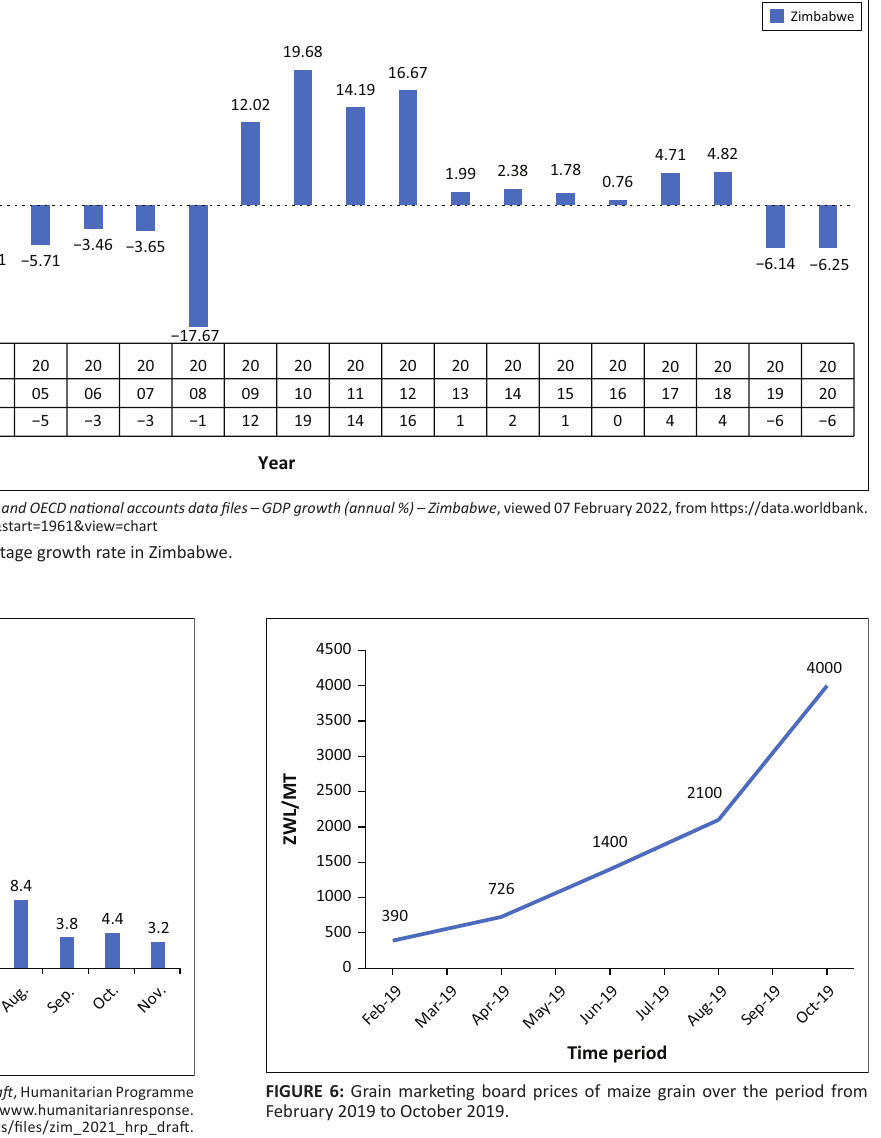
FIGURE 5: Monthly inflation rate for 2020 in Zimbabwe.